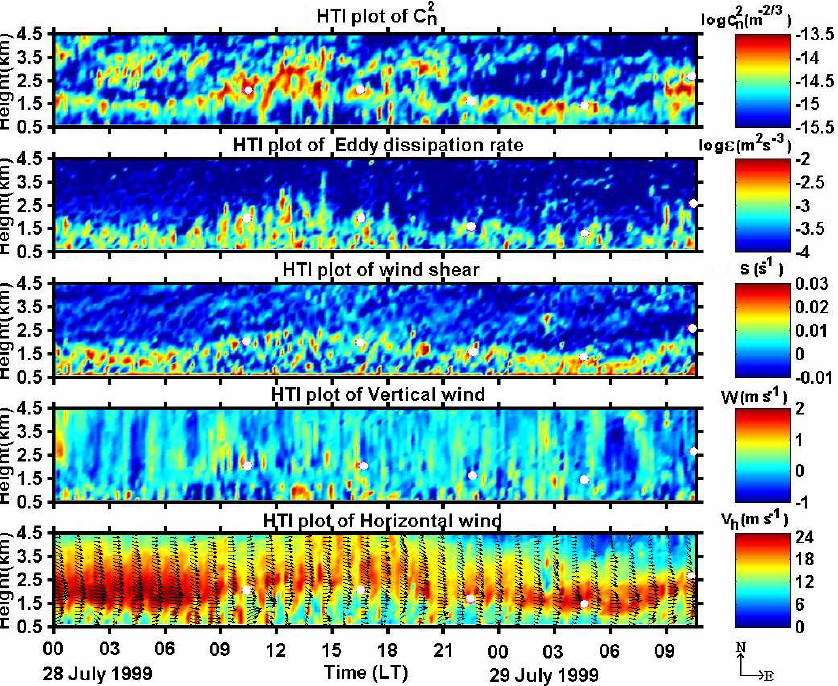
Fig. 5a. (Top to bottom) HTI panels show radio refractive index structure parameter ( C 2 n ) , eddy dissipation rate ( ε) , wind shear (S), vertical wind (W), horizontal wind speed ( V h ) with four hourly averaged wind direction, and observed during 28–29 July 1999. The white circles correspond to the boundary layer top estimated from radiosonde